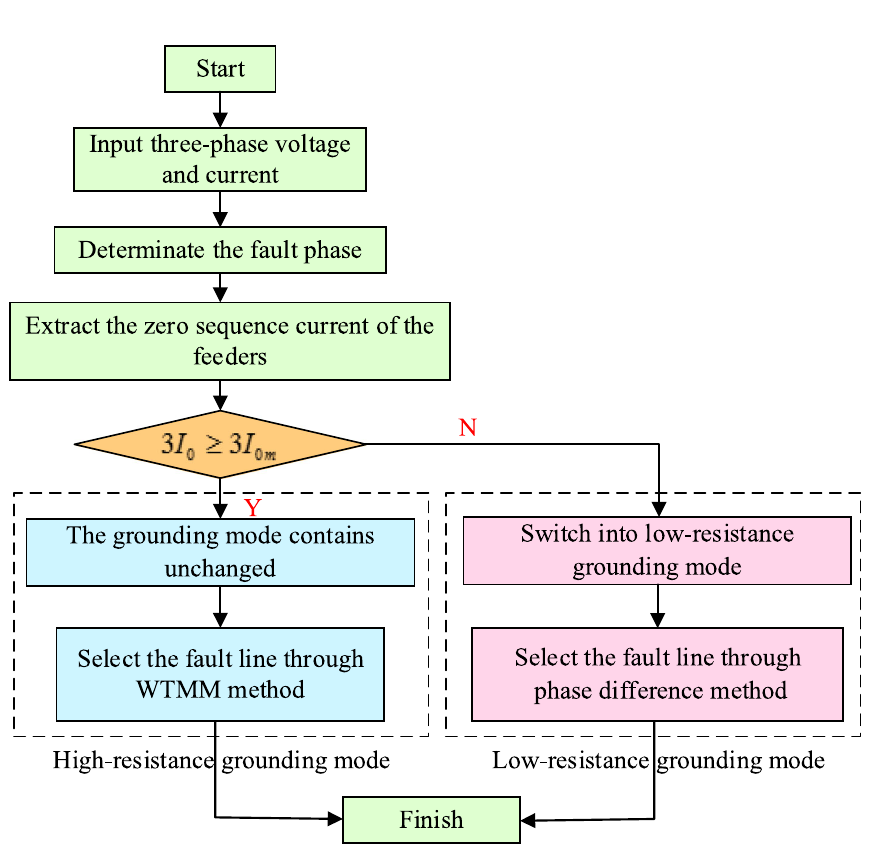
Fig. 2 Flowchart of the fault line selection